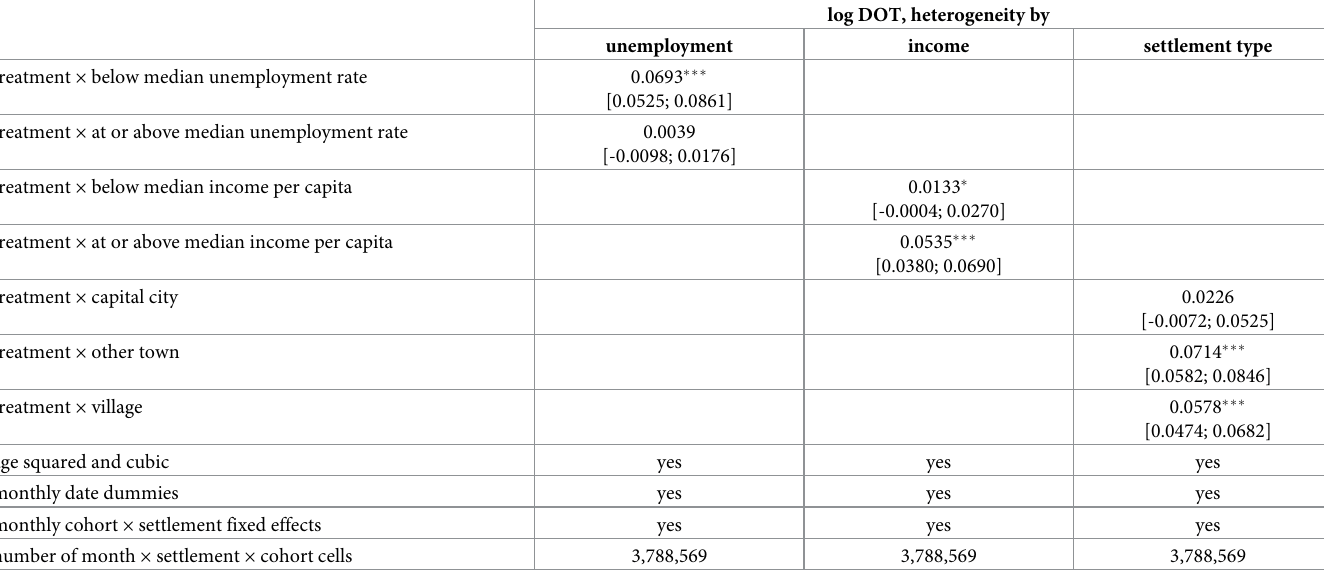
Table 5. Heterogeneity in the effect of the increased price subsidy on antibiotic use by settlement level